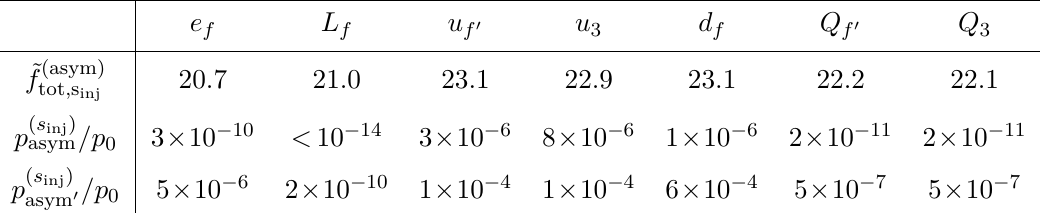
Table 2 . Asymptotic value of total distributions and the typical energy scales of the scaling solution p ( s inj ) asym and p ( s inj ) for s inj = ( e f , L f , u f 0 , u 3 , d f , Q f 0 , Q 3 ) asym 0